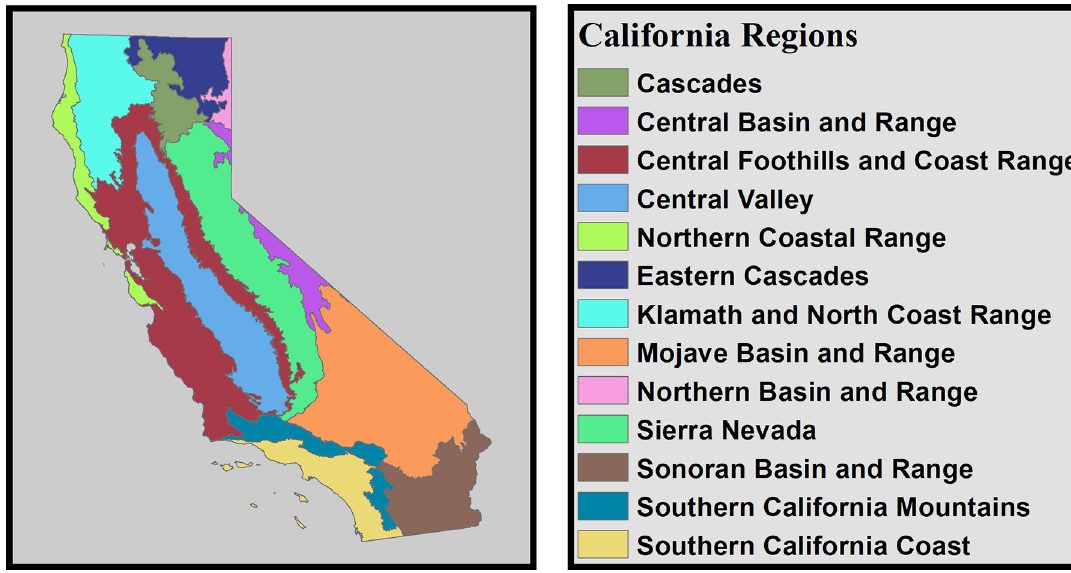
Fig 1. Regions of California, corresponding to CalVeg ecosystem provinces